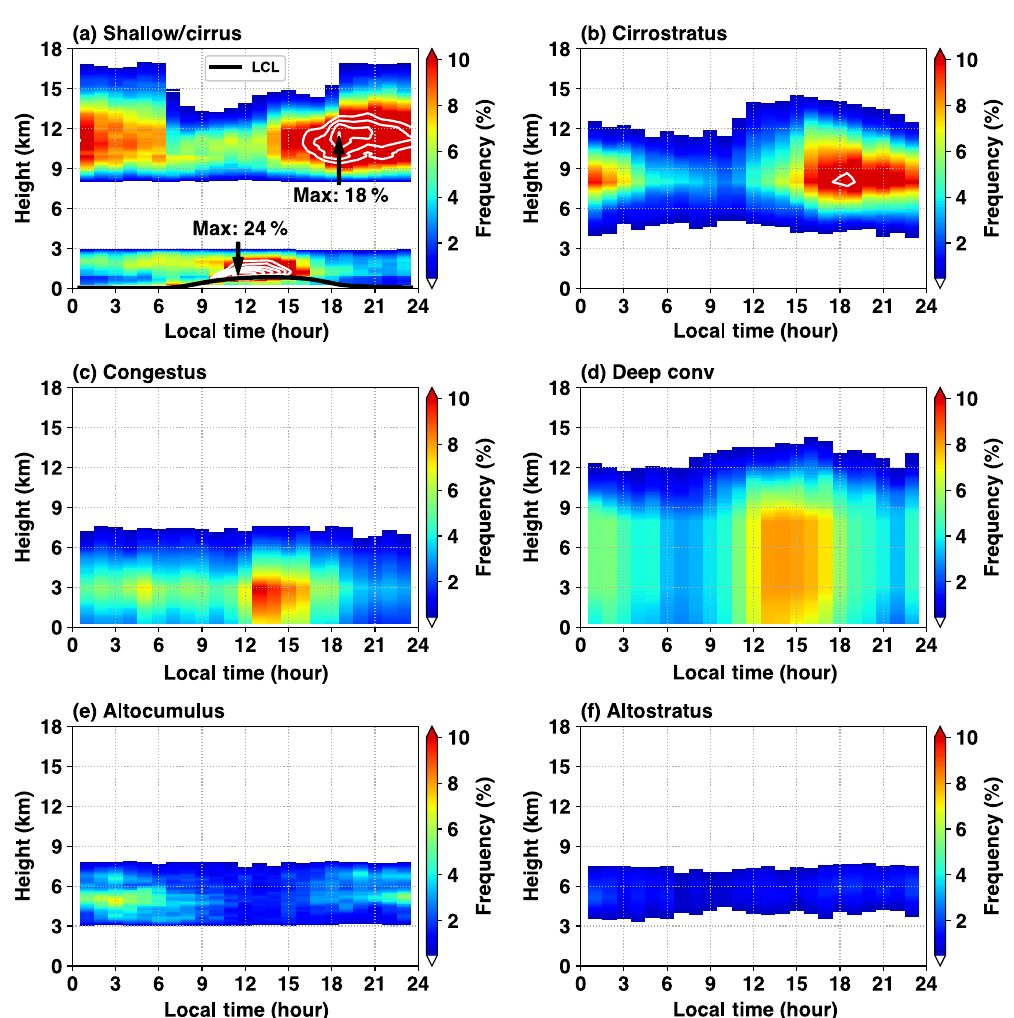
Figure 6. Composite diurnal cycle cloud fraction profiles segregated according to each of the seven cloud classification categories. White contours start at 10% and increments at 2%. Maximum cloud fraction values for shallow and cirrus clouds are marked in panel (a) . The black line in panel (a) plots the averaged LCL height estimated using surface